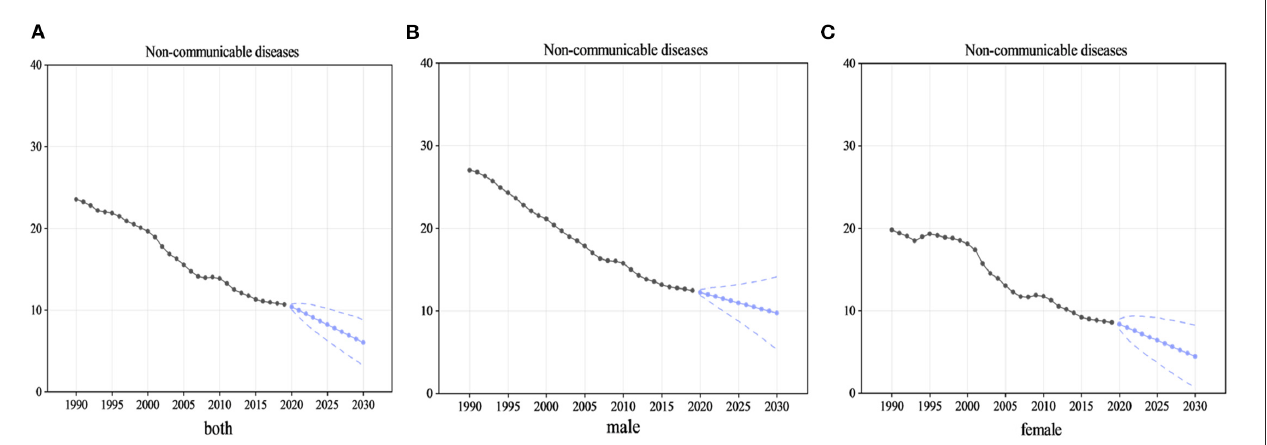
FIGURE6 Mortality rates of NCDs for adolescents from 1990 to 2019 and predicted up to 2030. (A) The trend and prediction of mortality rates in all adolescents, (B) the male adolescents, and (C) the female adolescents. In this figure, the black point and solid line denote NCDs mortality rates for adolescents from 1990 to 2019 estimated by GBD 2019. Blue point and solid line denote NCDs mortality rates for adolescents from 2020 to 2030 projected by the Autoregressive Integrated Moving Average model based on the mean rates from 1990 to 2017. Blue dashed lines denote 95% confidence intervals of the projected NCDs mortality rates.